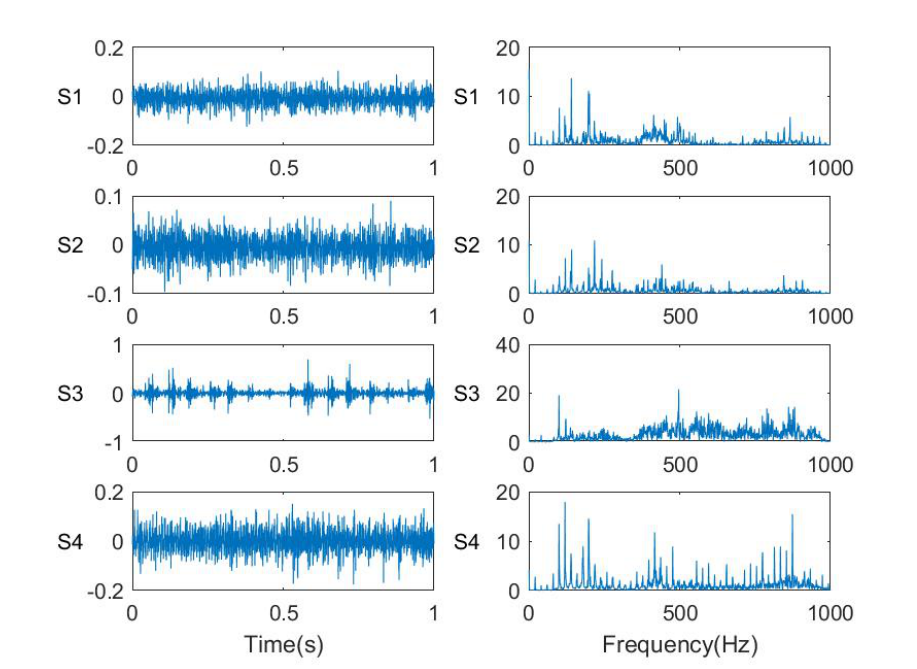
Figure 9. Waves of vibration signals in time and frequency domain under four bearing